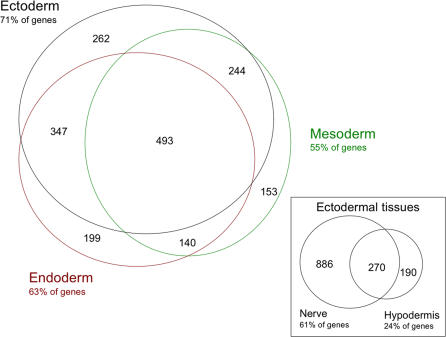
The Primordial Germ Layers' Main Sphere of Influence: Ectoderm (Neurons and Hypodermis), Mesoderm (Muscle), and Endoderm (Intestine)From the data, we see a fairly even distribution of expression between the germ layers: 71% of the 5′ DNA sequences express in ectoderm, 63% in endoderm, 55% in mesoderm, and about half from each germ layer contributes to the intersection of the three germ layers. Within the ectoderm (see inset), we see that there is a preponderance of neural-specific expression (61%) relative to hypodermal-specific expression (14%). There are very few hypodermal 5′ DNA sequences that do not also express in either the nerve, muscle, or intestine.